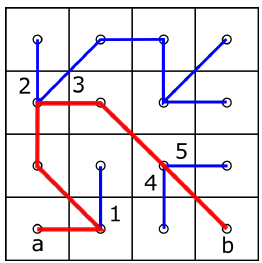
Figure 6: A road R 2 ( a , b ) (in red) and the 5 branches in T 2 with respect to R 2 ( a , b ) (in blue) for the IFS for the square in Fig. 3. Branches 2 and 3 contain a point in V 1 \ R 2 ( a , b ) ; branches 1, 4, and 5 do